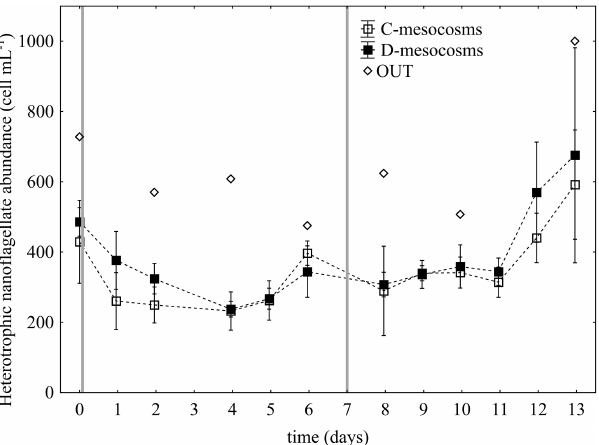
Figure 7. Ratios virus and bacterial abundance (mean ± standard deviation of three replicate mesocosms) in D- and C-mesocosms and OUT samples at surface (a) , 5m (b) and 10m (c) depth during the DUNE-R experiment. Grey vertical bars represent the dust seedings.